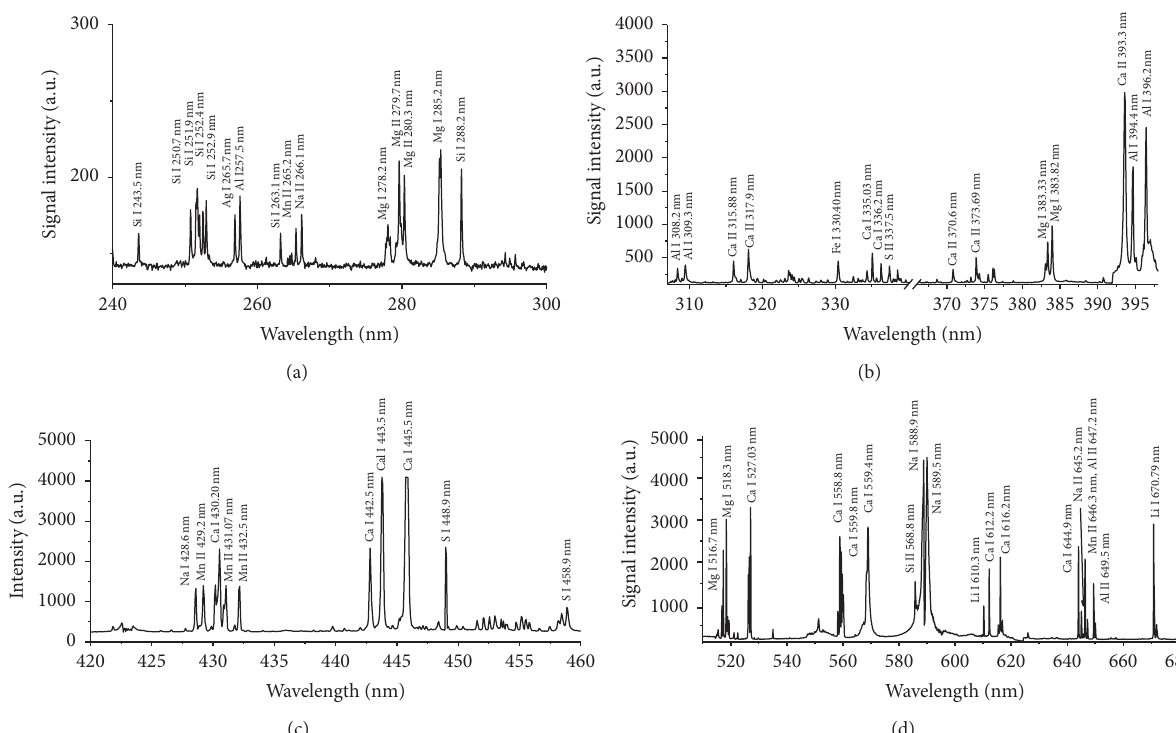
Figure 2: The representative emission spectrum of lapis quartz along with the relevant atomic emission identified, covering a spectral range of 240–680